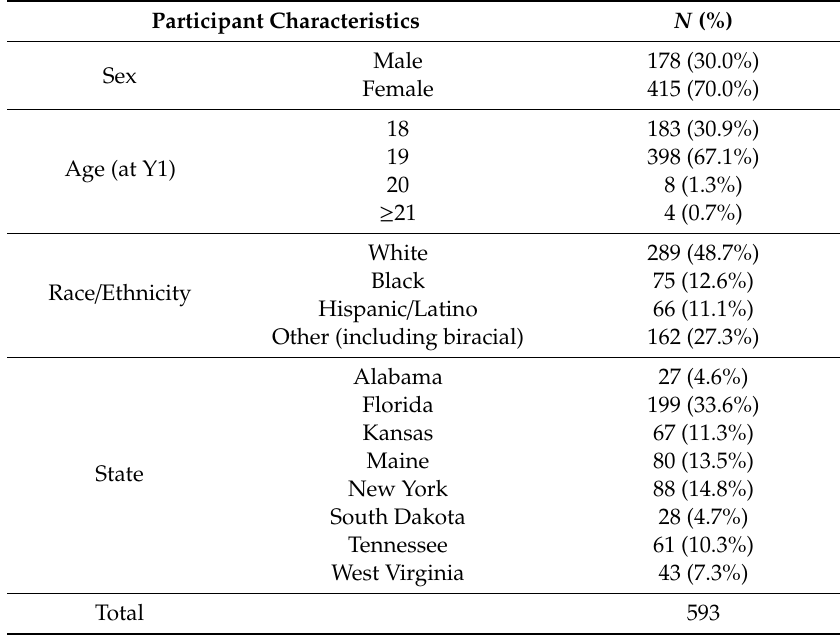
Table 1. Participant characteristics. Distribution of the overall sample ( N = 593) across pertinent demographic characteristics, and university